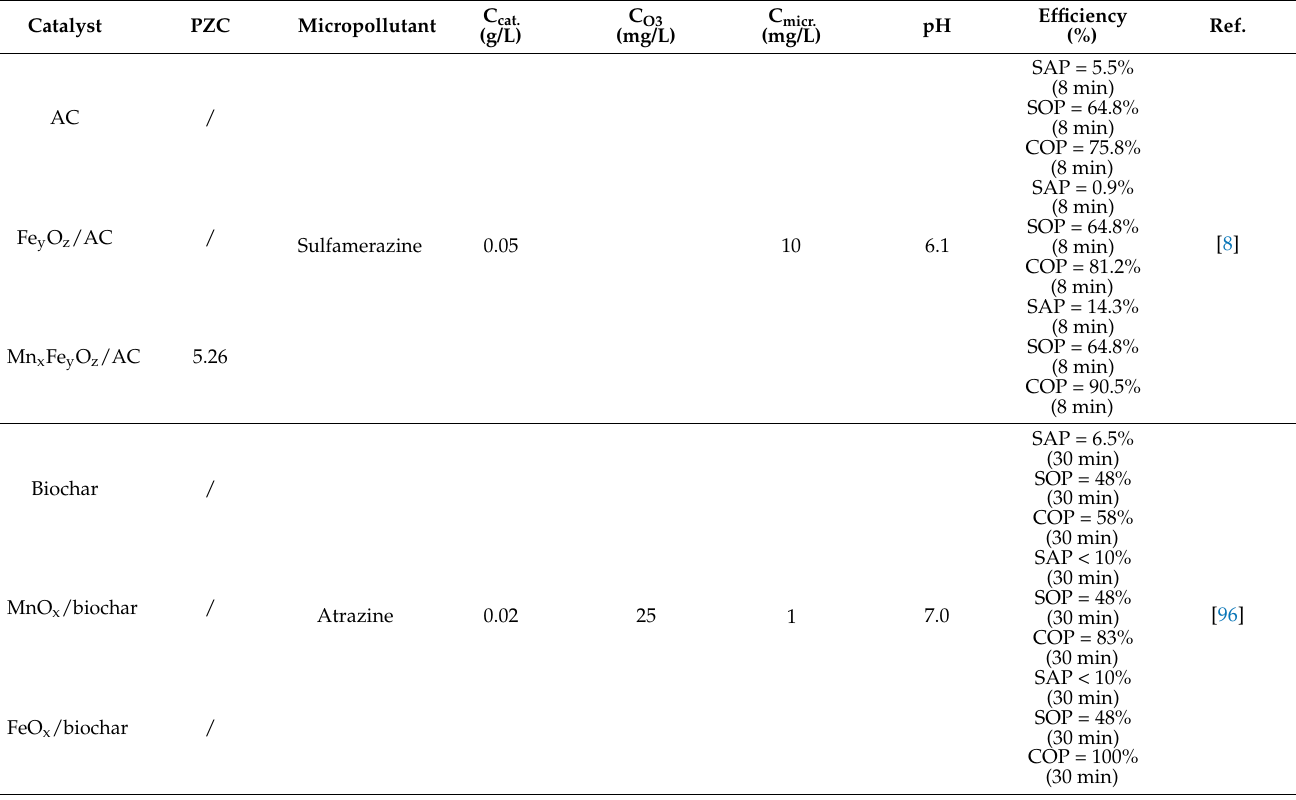
Table 4. Carbons used as catalysts in the heterogeneous catalytic ozonation process at the pH range